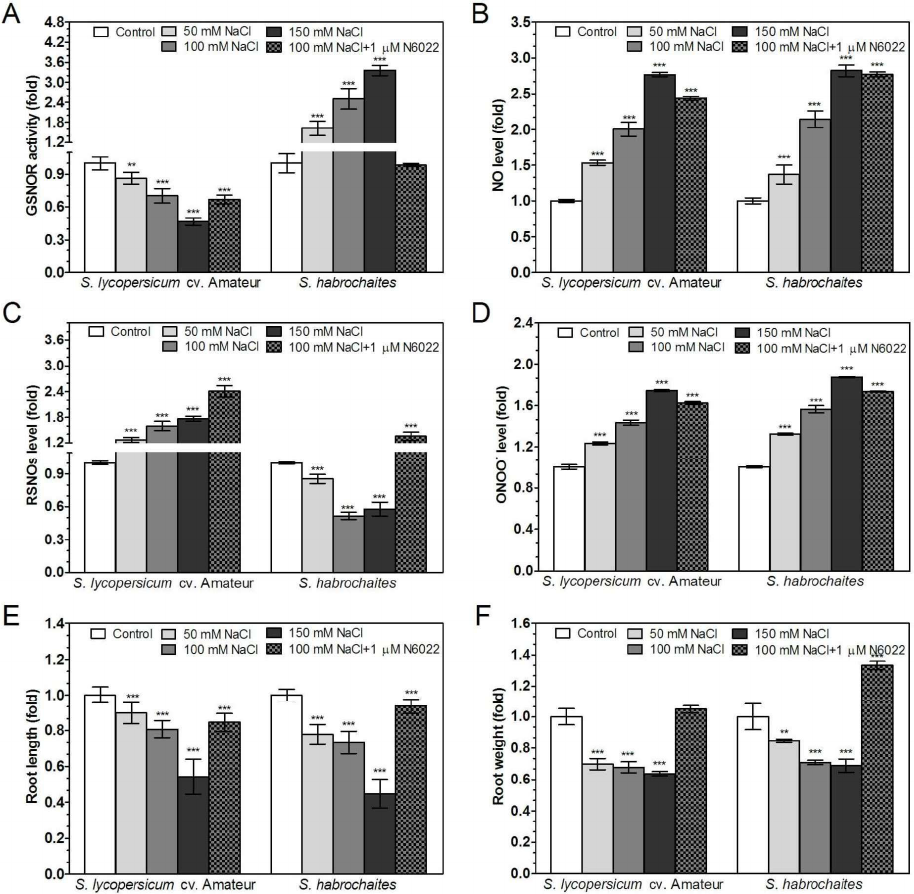
Figure 5. E ff ect of salinity stress on GSNOR activity, RNS levels and root growth in two Solanum spp. genotypes. Plants were grown in the growth medium containing 50, 100, 150 mM NaCl or combination of 100 mM NaCl with 1 µ M N6022. ( A ) GSNOR activity was evaluated spectrophotometrically at 25 ◦ C by monitoring the decrease of NADH absorbance at 340 nm. ( B ) Changes in NO levels in the root apical parts were monitored by confocal microscopy using 20 µ M DAF-FM-DA. ( C ) The S-nitrosothiol content was determined by the modified Saville method. ( D ) Changes in ONOO − levels in the root apical parts of roots were monitored by confocal microscopy using 20 µ M APF. E ff ect of salinity stress on plant growth was evaluated as ( E ) root lengths and ( F ) root fresh weights. As negative controls for NO and ONOO − determination, roots were pre-incubated with 200 µ M NO scavenger cPTIO or 20 µ M ONOO − scavenger ebselen, respectively, which completely abolished the fluorescence signal (data not shown). The data are presented as means ± SD (A–D: n ≥ 3; E–F: n = 30) relative to the value of control plants grown without NaCl. Significantly di ff erent means from the control values are denoted by asterisks (ANOVA, * p < 0.05, ** p < 0.01, *** p < 0.001).